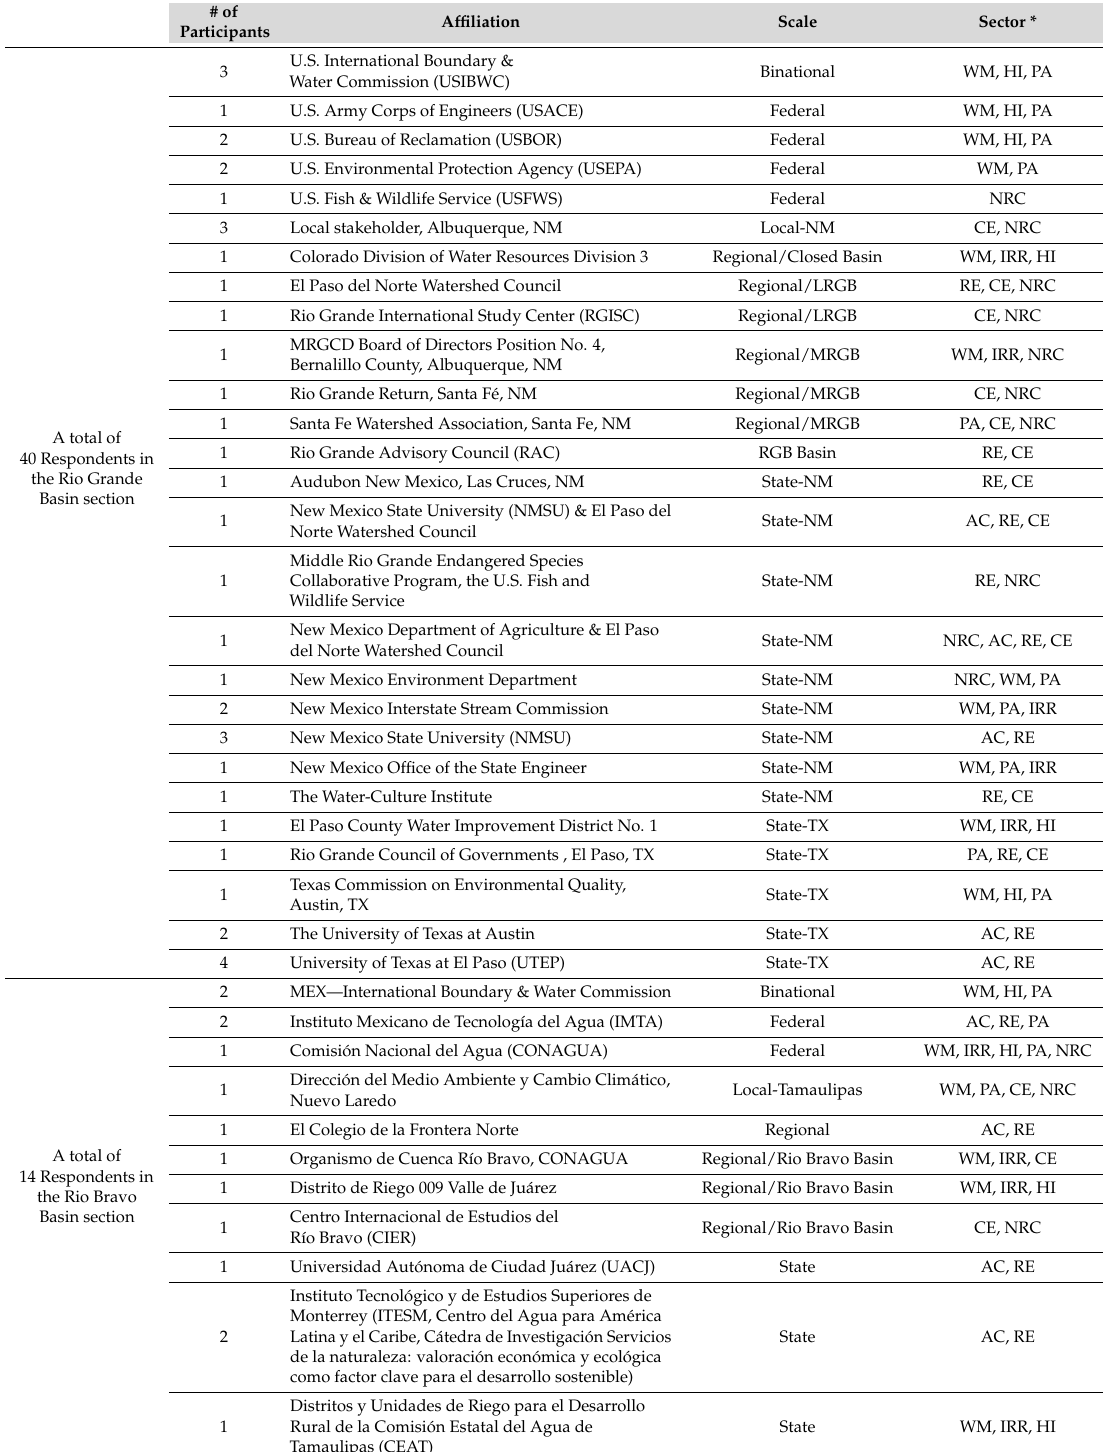
Table A2. A total of 54 Respondents in the Rio Grande/Rio Bravo Basin